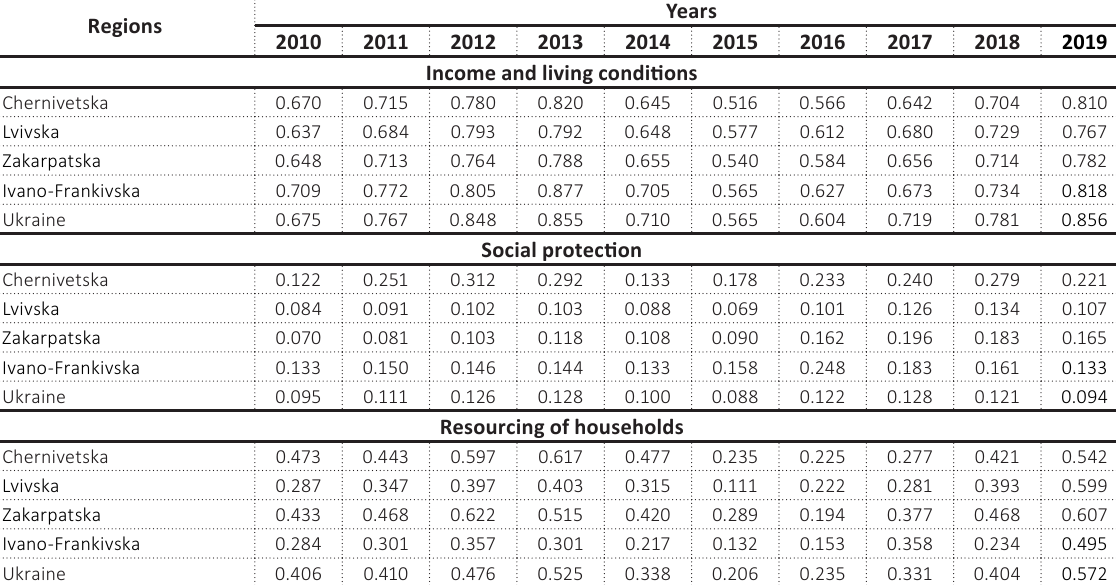
Table 3. Weight coefficients for the groups of financial wellbeing determinants, 2010–2019 Source: Compiled based on the data in Table 2 and Figure 1.